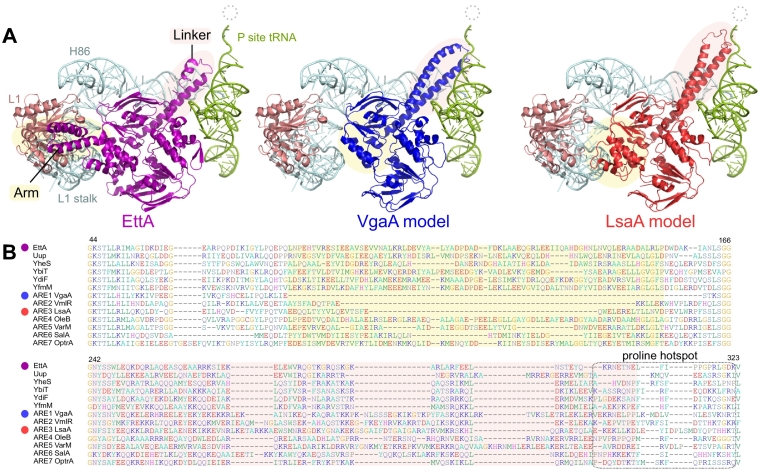
AREs tend to have relatively long linker regions that potentially extend toward the ribosome bound antibiotics. (A) The structure of EttA and its interacting ribosomal components from PDB 3J5S[17] is shown alongside homology models of S. aureus VgaA and E. faecalis LsaA, using 3J5S as the template, with de novo modeling of the linker regions. The dotted circle shows the relative location of PTC-inhibiting antibiotics. Arm and linker regions are shaded in yellow and pink, respectively. (B) Extracts from the multiple sequence alignment of E. coli and B. subtilis ABCFs, and representative AREs, containing the Arm (yellow shading) and Linker (turquoise shading) subdomains. Alignment numbering is according to the EttA sequence. A boxed region shows a region that is particularly rich in proline and polyproline in various ABCF family members.